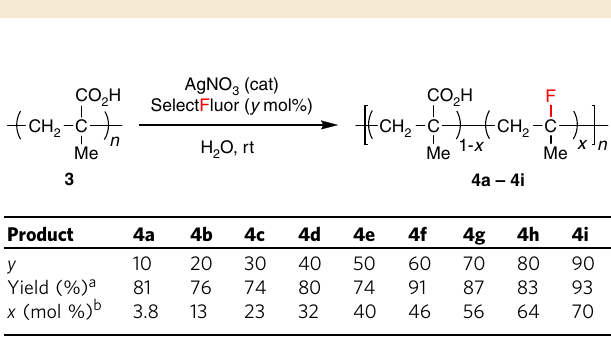
Table 2 Controlled decarboxylative fl uorination of poly